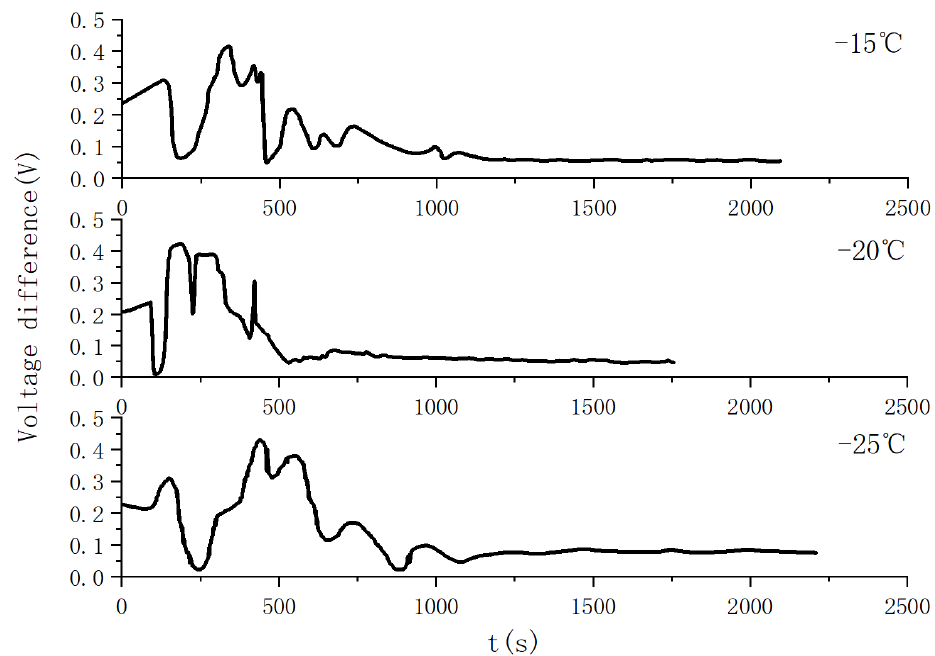
Figure 6. Graphs of the voltage difference change in Stack A with time.